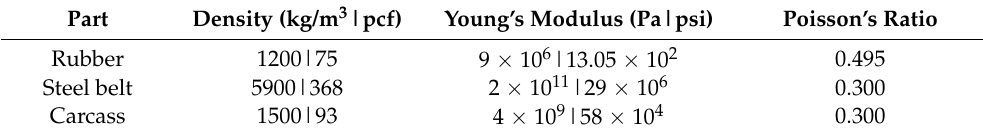
Table 5. Material properties of the FE tire model